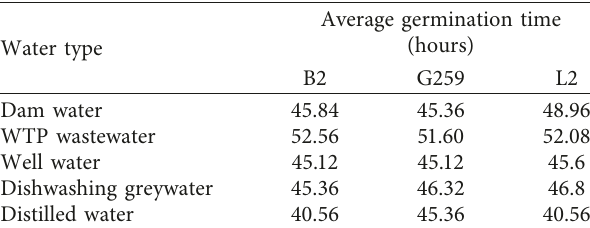
Table 6: Average germination time of the seeds of three ecotypes of okra according to the irrigation